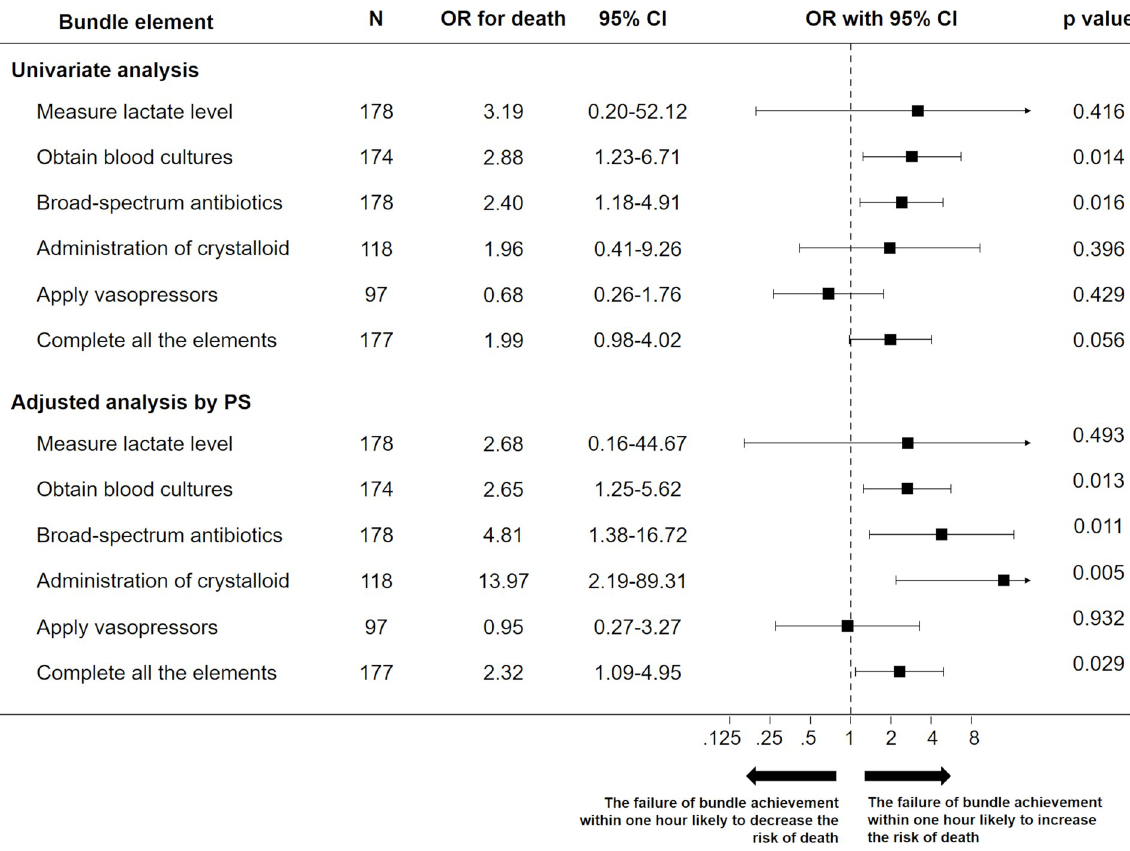
Fig 2. Association between mortality and adherence to each bundle component within 1 hour. Univariate and multivariate-adjusted ORs with 95% CIs for mortality risk are represented as forest plots. Inverse probability of treatment weighting analysis with propensity score was used as the adjustment method. OR odds ratio, CI confidence interval, PS propensity